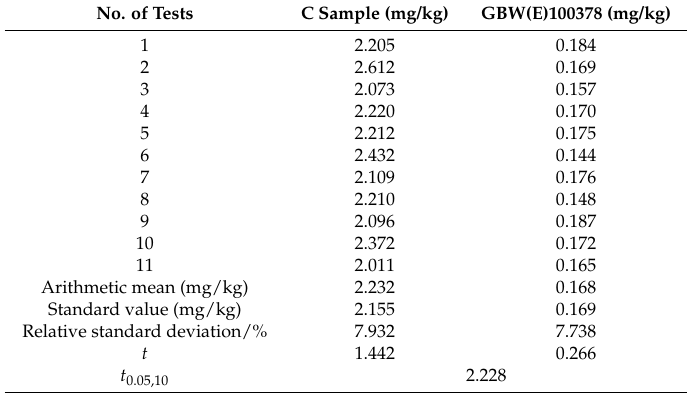
Table 2. Accuracy of the instrument. Tested and verified by standard and contaminated